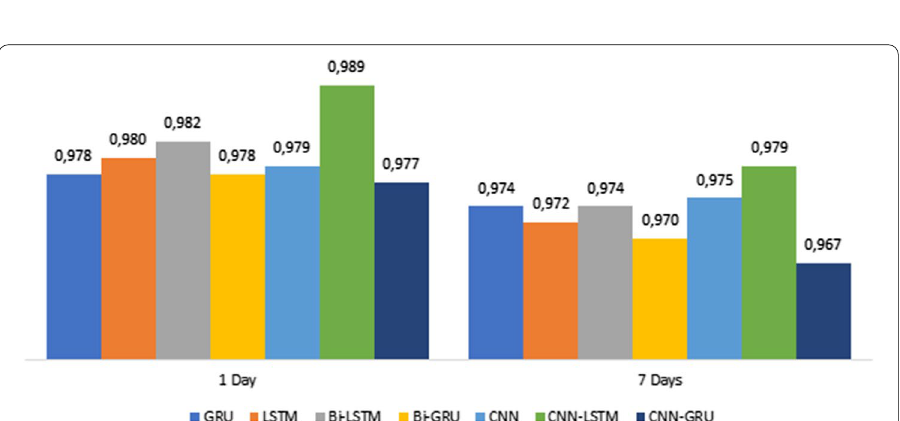
Fig. 15 Comparison of the R 2 for the 1day and 7day lag for the different deep learning